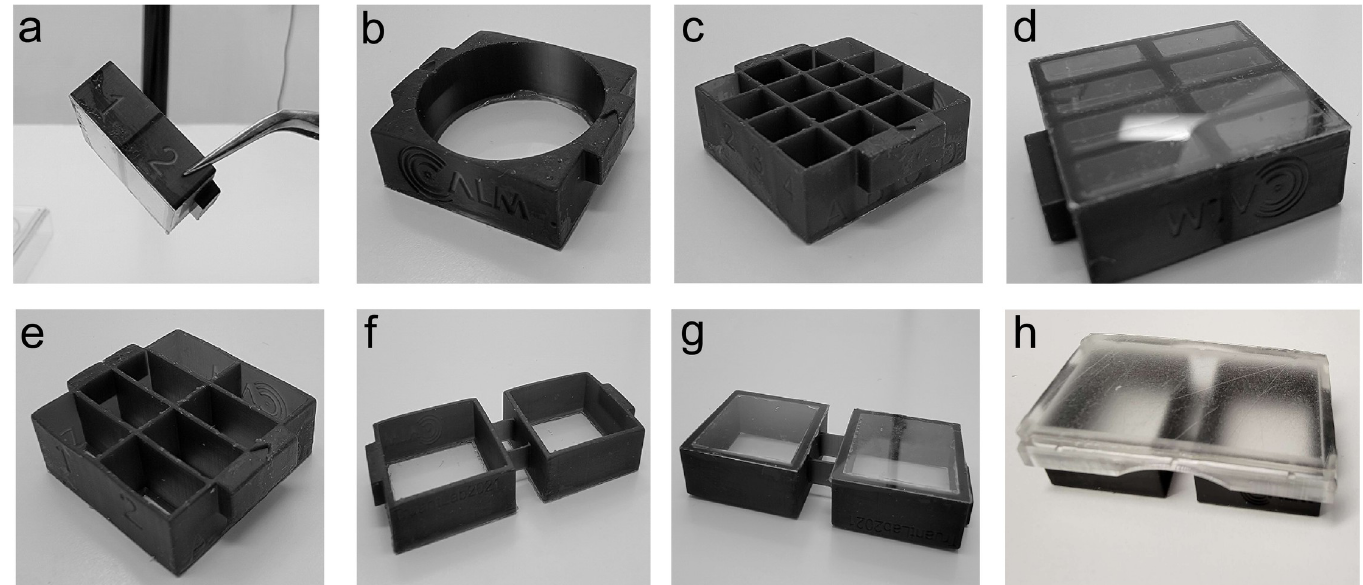
Fig 2. Examples of varieties of chamber designs in Mod3D. (a,b) Examples of embossed alphanumeric labels on 4-well (750 μ l per well) or 16-well (145 μ l per well) chambers. (c) Round single well design (2.8 ml). (d) Example of glass bonding using RTV silicone at the bottom of the chambers. (e) Example of 8-well chambers (260 μ l per well). (f) Bridged 2-well chambers in 22x50 mm format, shown bonded to 22x22 mm glass coverslips in (g). (h) Bridged 2-well chambers bonded to a 22x50 mm glass coverslip, with reusable plastic lid.